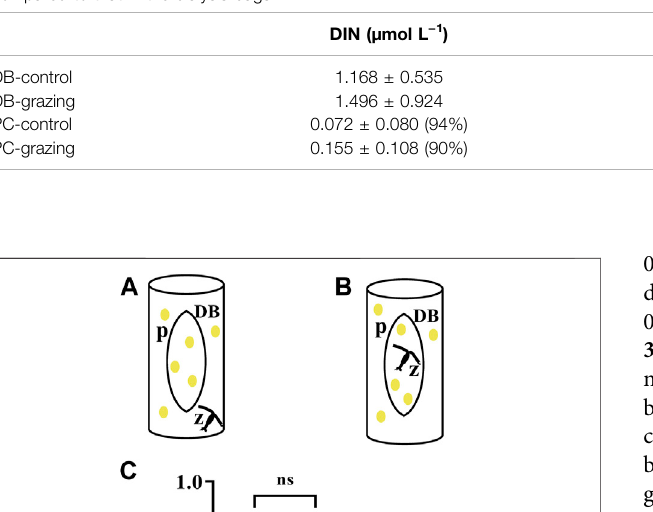
TABLE 1 | The concentration of dissolved inorganic nitrogen (DIN, nitrate plus nitrite), soluble reactive phosphorus (SRP) and silicate [Si(OH) 4 ] remained in the dialysis bags (DB) and polycarbonate bottles (PC) at the end of grazing experiment. The relative values in parenthese indicate decreased proportions of the nutrients in the bottles compared to that in the dialysis bags.